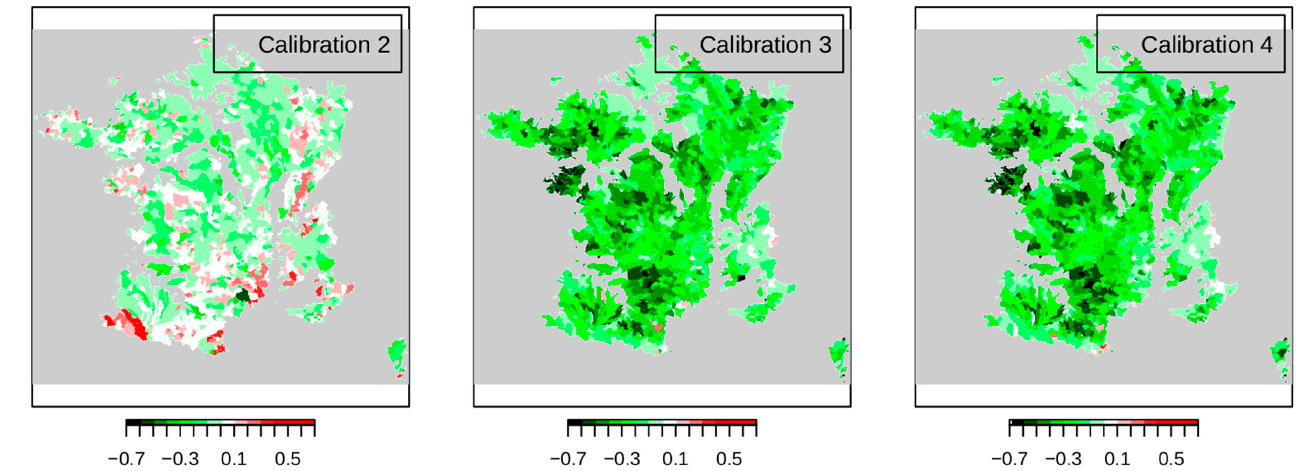
Figure 7. Mapping of the difference between summer values and winter values.